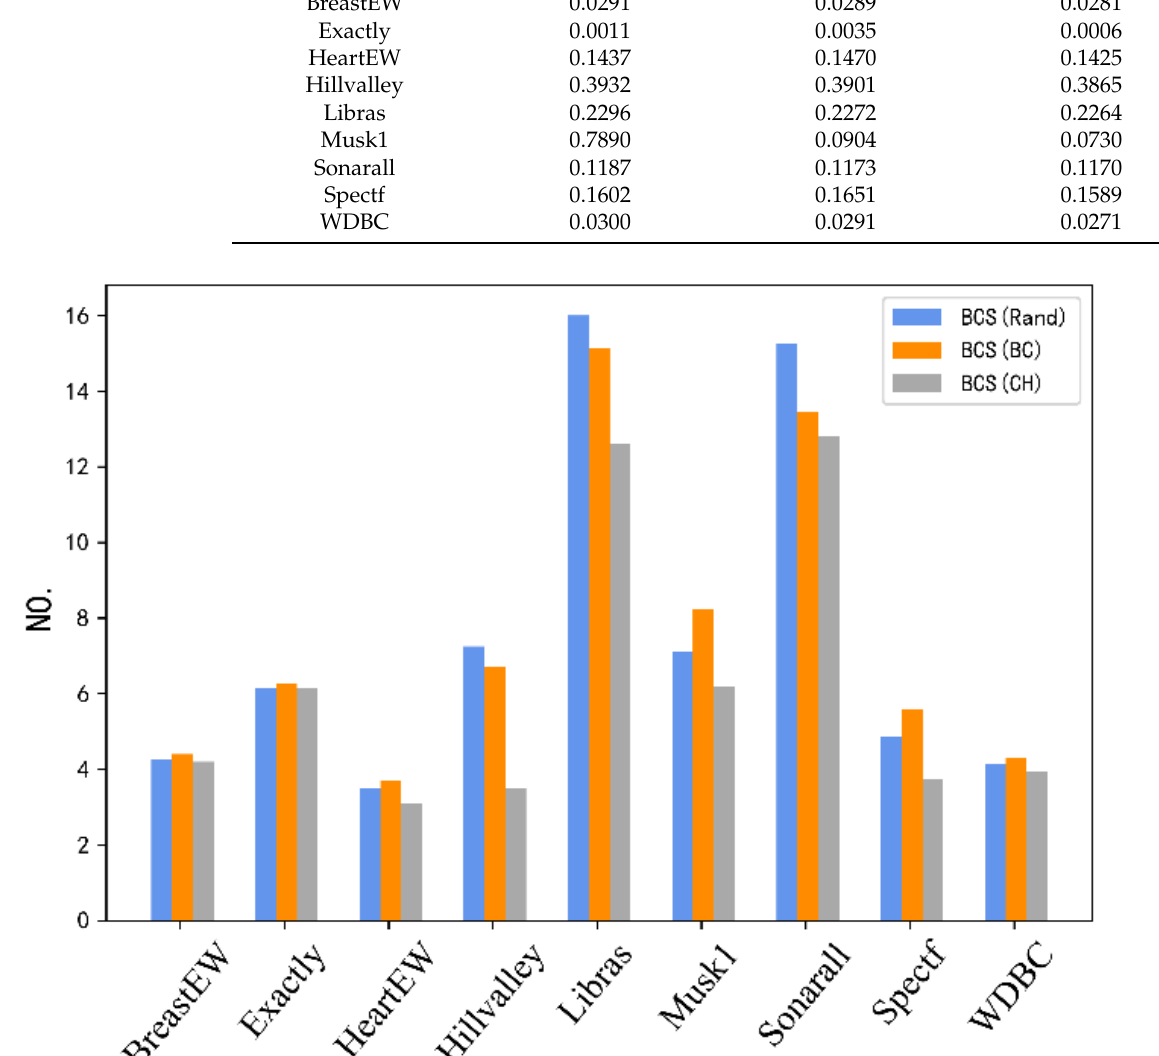
Figure 7. Average histogram of the number of features for the three algorithms.